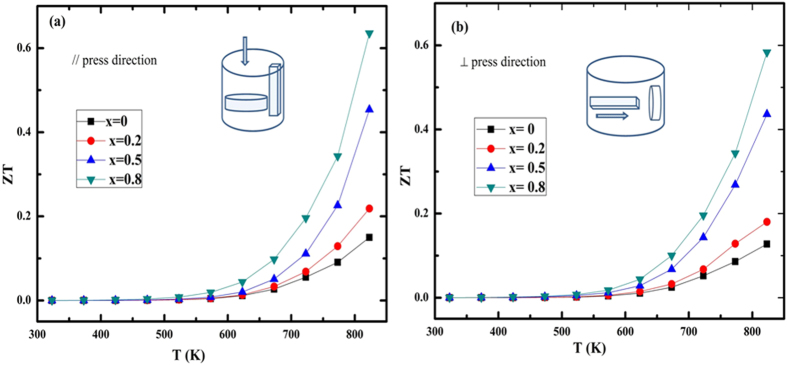
Temperature dependence of the ZT values of SnS1−xSex (x = 0, 0.2, 0.5, 0.8) solid solutions (a) parallel (//) and (b) perpendicular (⊥) to the SPS–pressurizing direction.